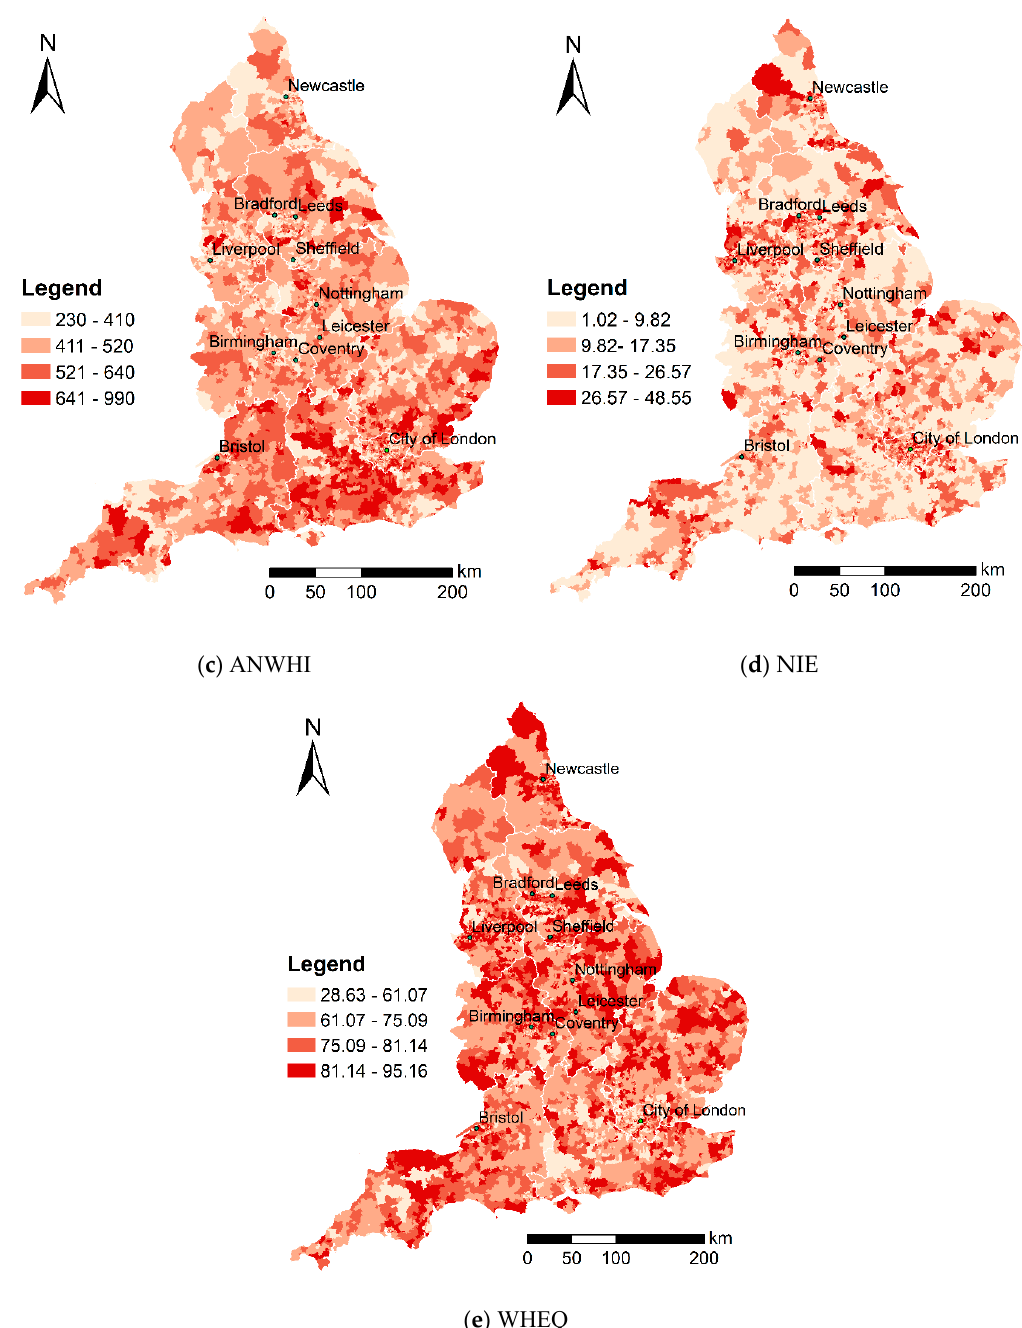
Figure 2. MSOA ‐ level spatial distribution of explanatory variables across England. Figure 2. MSOA-level spatial distribution of explanatory variables across